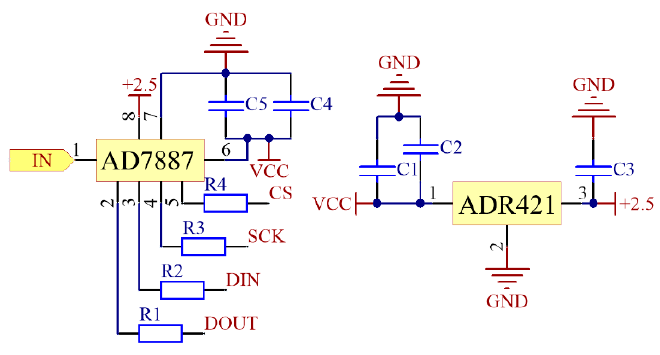
Figure 4. Schematic diagram of AD7887 and ADR421.